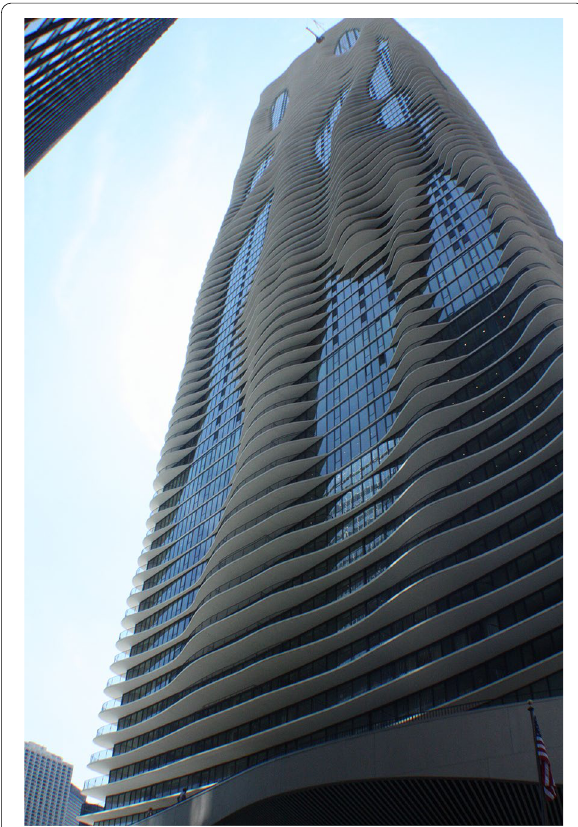
Fig. 25 The Metlife Building threatens the presence of the neoclassical